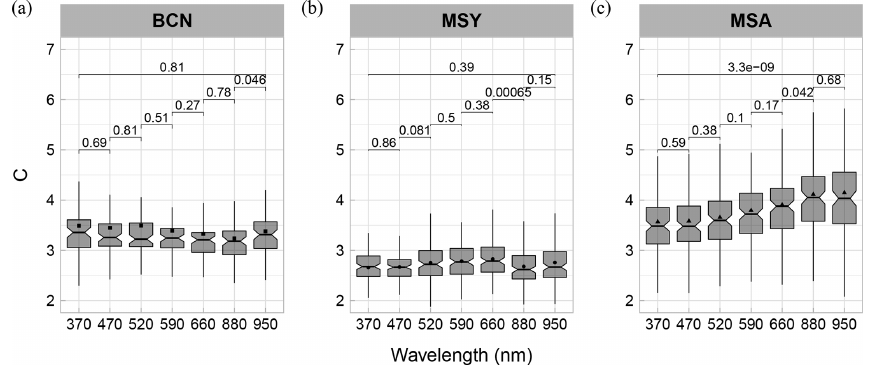
Figure 4. Wavelength dependence of C at BCN, MSY and MSA comparing b atn from the AE33 measured at each wavelength and b abs interpolated and extrapolated to the same wavelength from PP_UniMI. Box plots have been obtained as in Fig. 3 with the addition of the mean value of the distribution for each wavelength represented by a marker. The values above the box plots between adjacent wavelengths and between 370 and 950nm wavelength box plots show the obtained p values, with p < 0 . 05 meaning a statistically significant